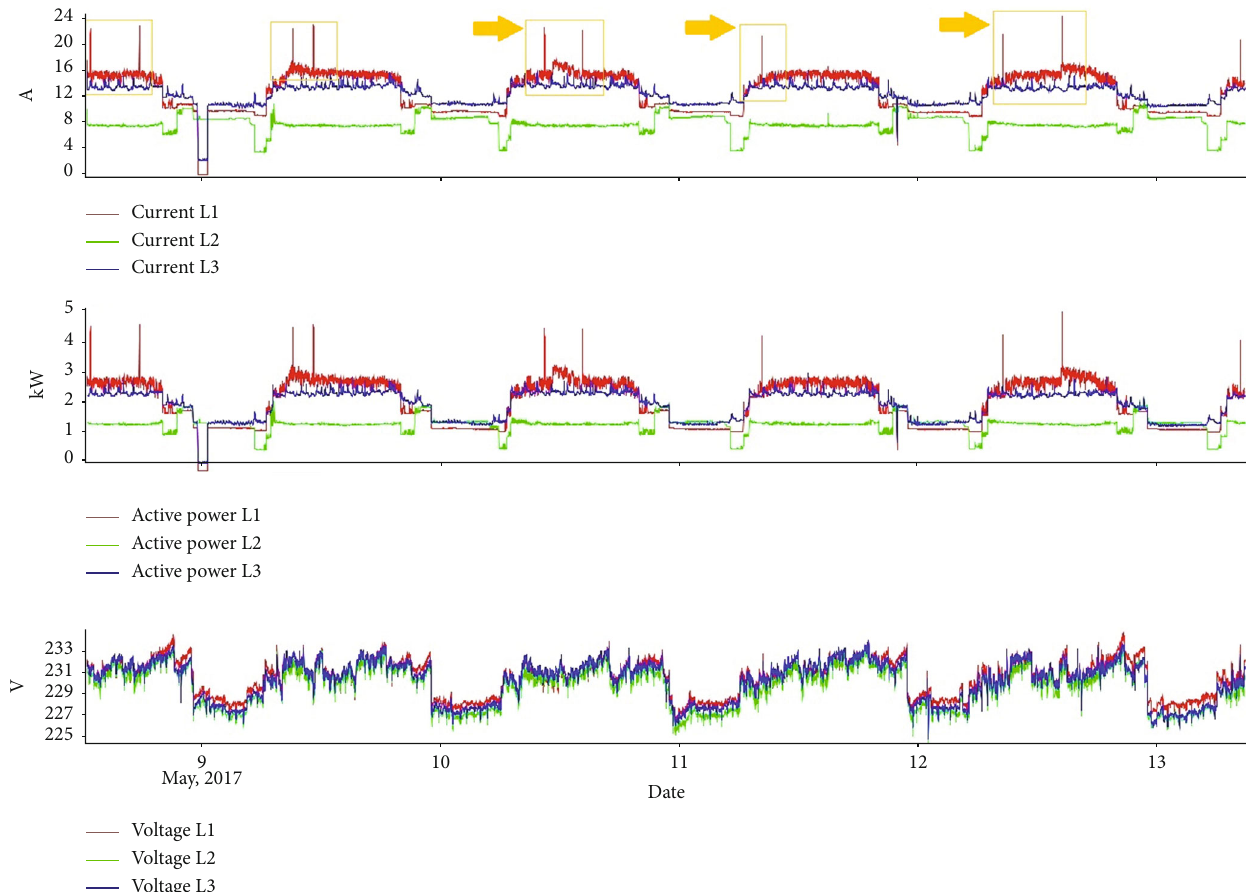
Figure 6: Utility schedule before